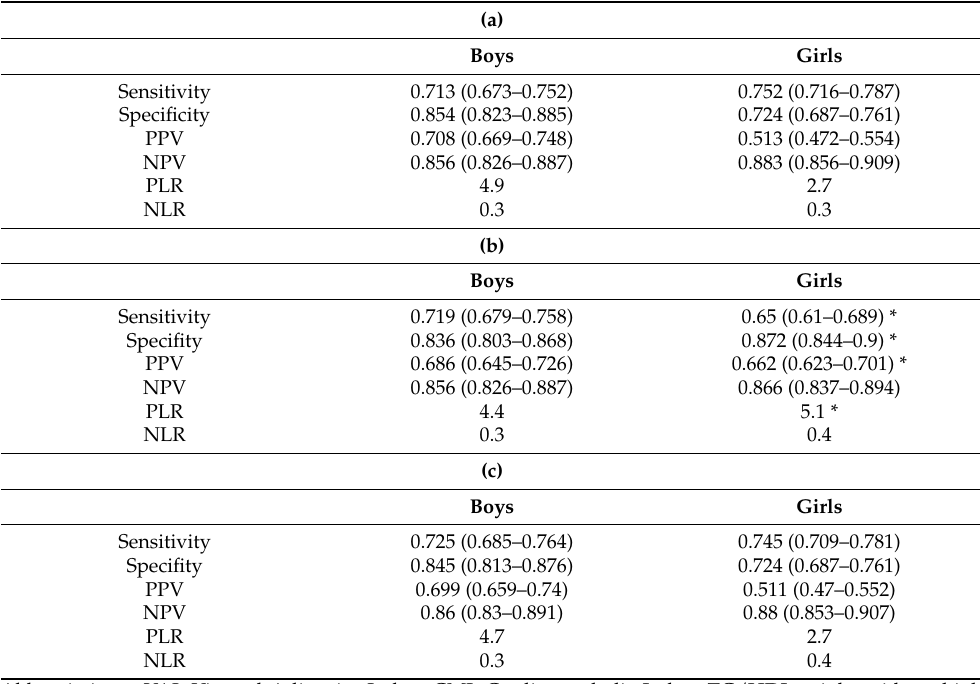
Table 3. Sensitivity, specificity, positive likelihood ratio (PLR), negative likelihood ratio (NLR), posi- tive predictive value (PPV), and negative predictive value (NPV) of VAI ( a ), CMI ( b ) and TG/HDL- Cholesterol ( c ).